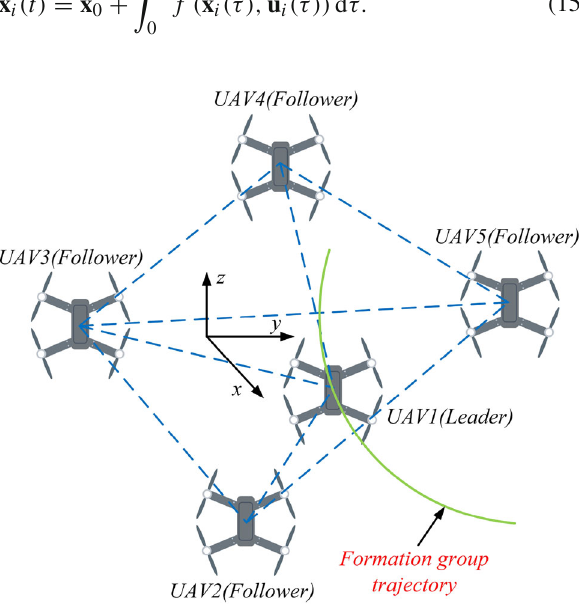
Fig. 7 Structure of leader–follower